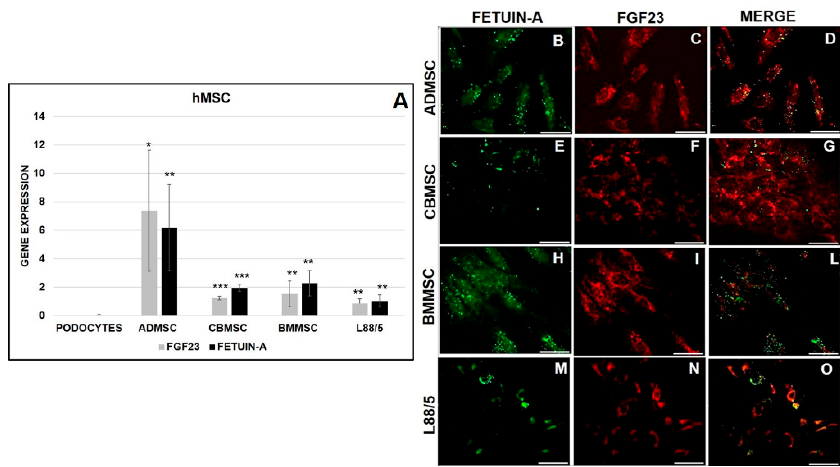
Figure 3. qRT-PCR of Fetuin-A and FGF23 mRNA expression in PODO (control negative), ADMSC, CBMSC, BMMSC, and L88/5 cell line ( A ). IF of Fetuin-A ( B , E , H , M ), FGF23 ( C , F , I , N ), and MERGE